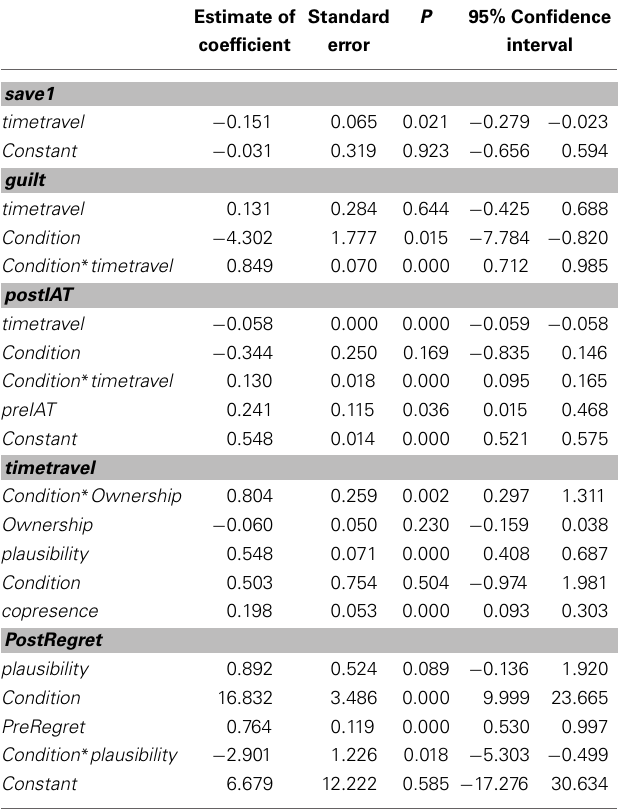
Table 5 | Path analysis corresponding to Figure 3, n = 32.